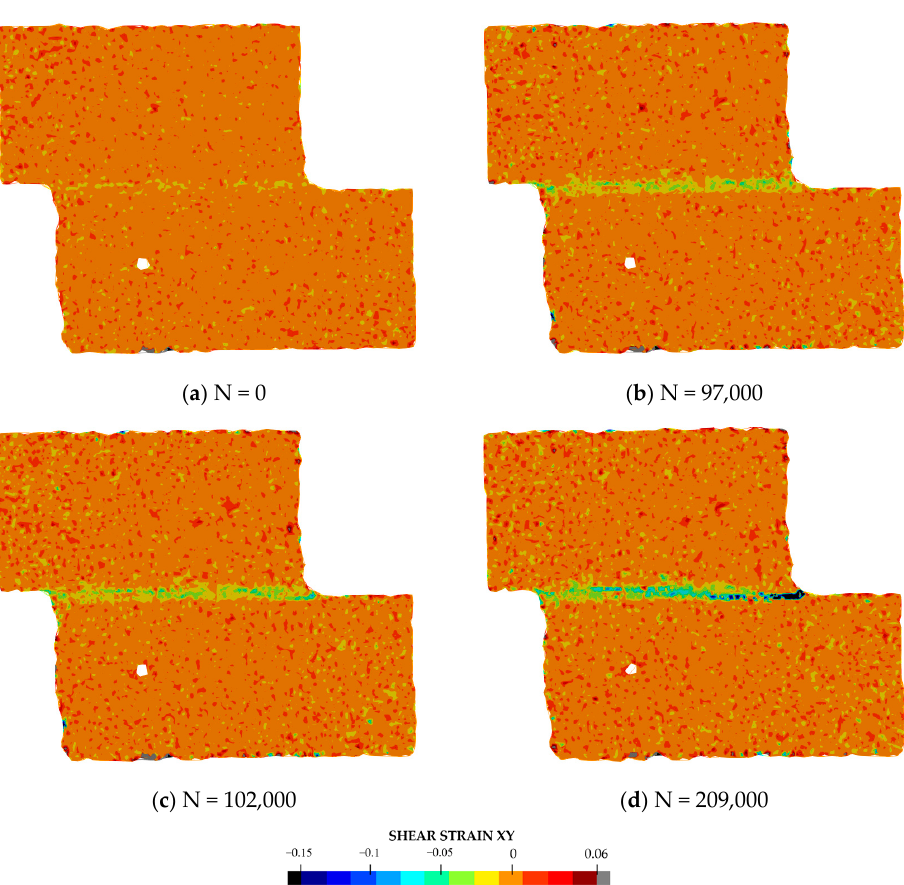
Figure 4. Example of peel strain values measured by digital image correlation during a test: ( a ) at the beginning of the test; ( b ) last acquisition before crack onset; ( c ) first acquisition after crack on- set; ( d ) a few cycles before the final failure.